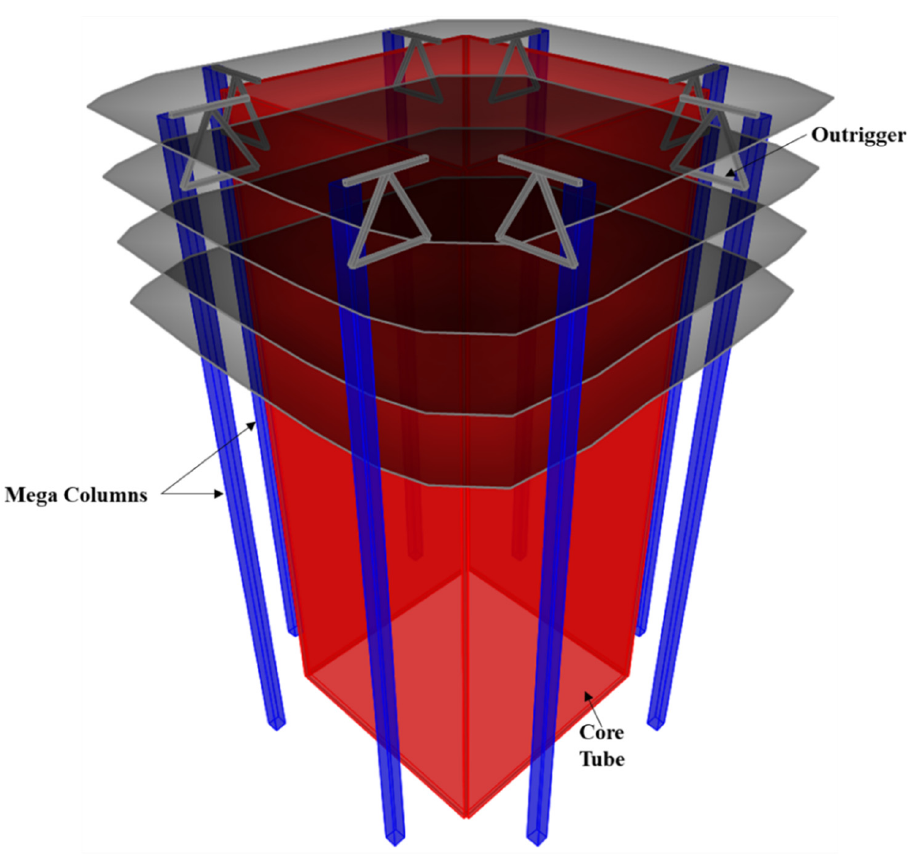
Figure 1. Mega columns in typical high-rise construction.